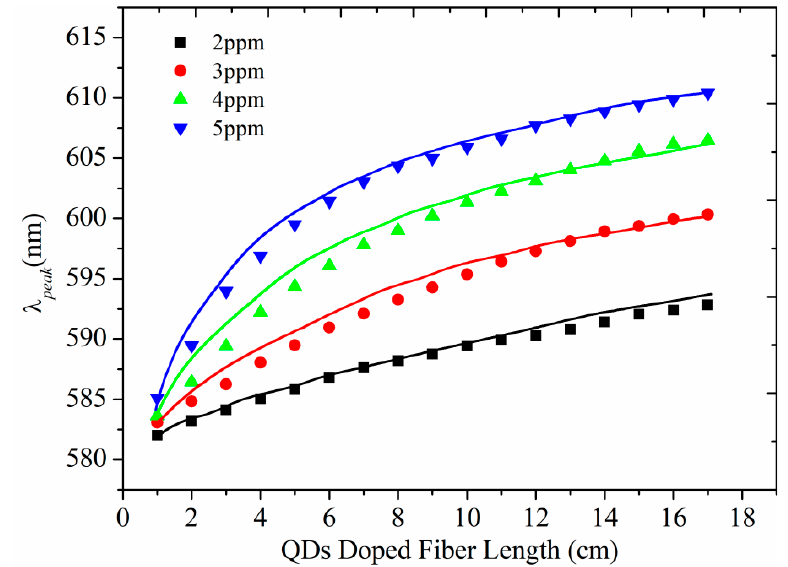
Figure 4. Peak wavelength of the CdSe/ZnS QD-doped POFs as a function of the doped fiber length (the solid lines were the simulation results, and the dots were the experimental results).